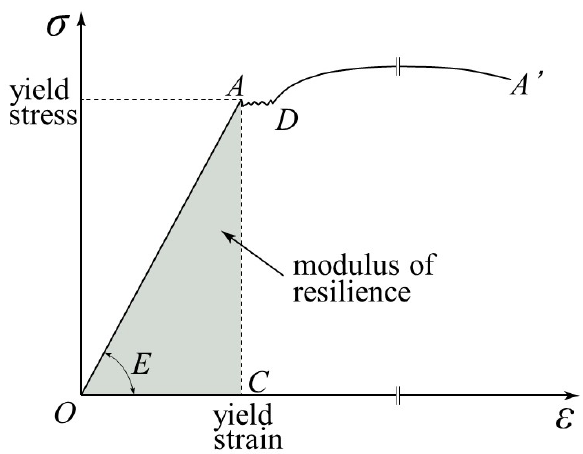
Figure 1. A typical stress–strain diagram of mild steel.